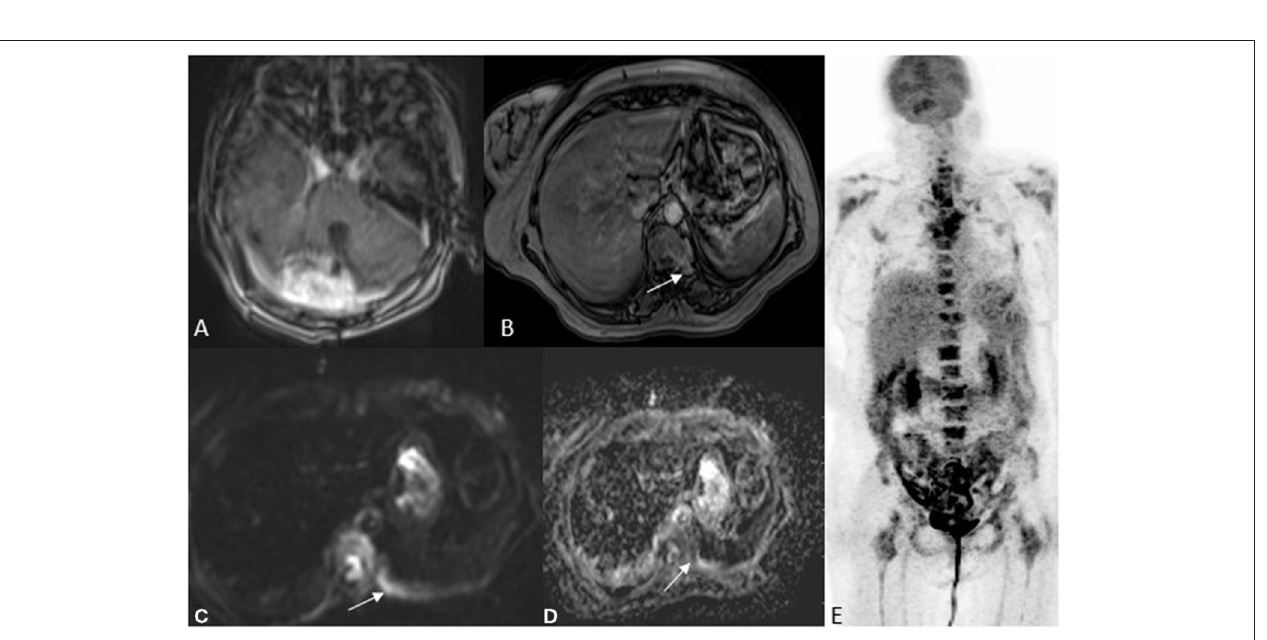
Frontiers in Neurology |